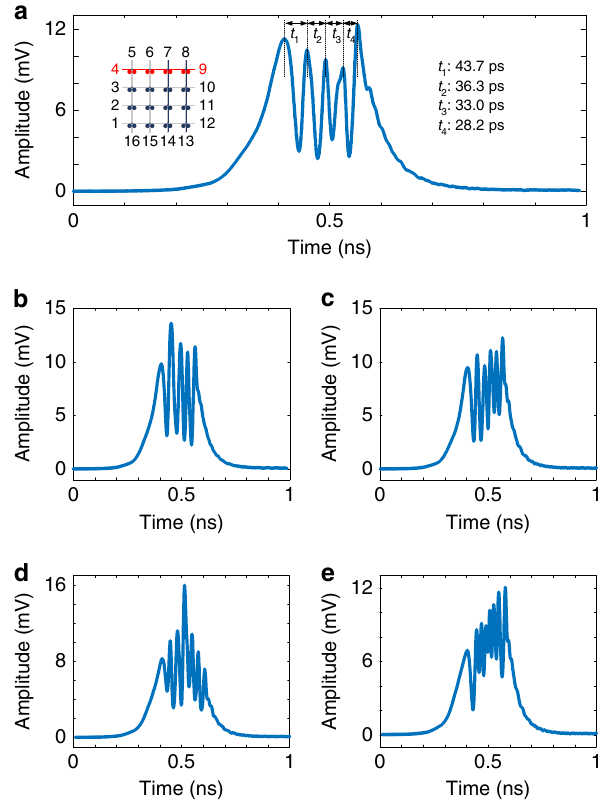
Fig. 5 Experimental results with photonic FPDA signal processor operating as optical pulse shaper. a Generated microwave waveform with an up-chirped pro fi le. b – e Generated microwave waveforms with recon fi gurable peak number and